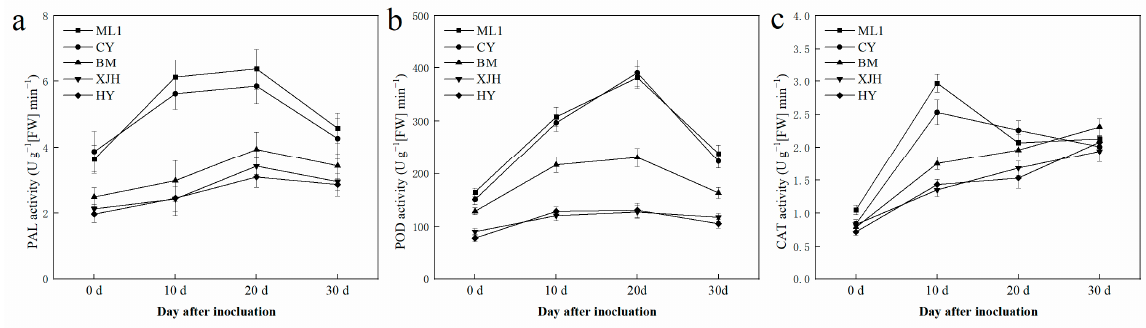
Figure 5. PAL ( a ), POD ( b ), and CAT ( c ) activity in the phloem of five kiwifruit cultivars canes after 30 days inoculation of Pseudomonas syringae pv. actinidiae (Psa). The data represent means from three biological replicates. Error bars = SD. Columns with different letters are significantly different at p < 0.05.